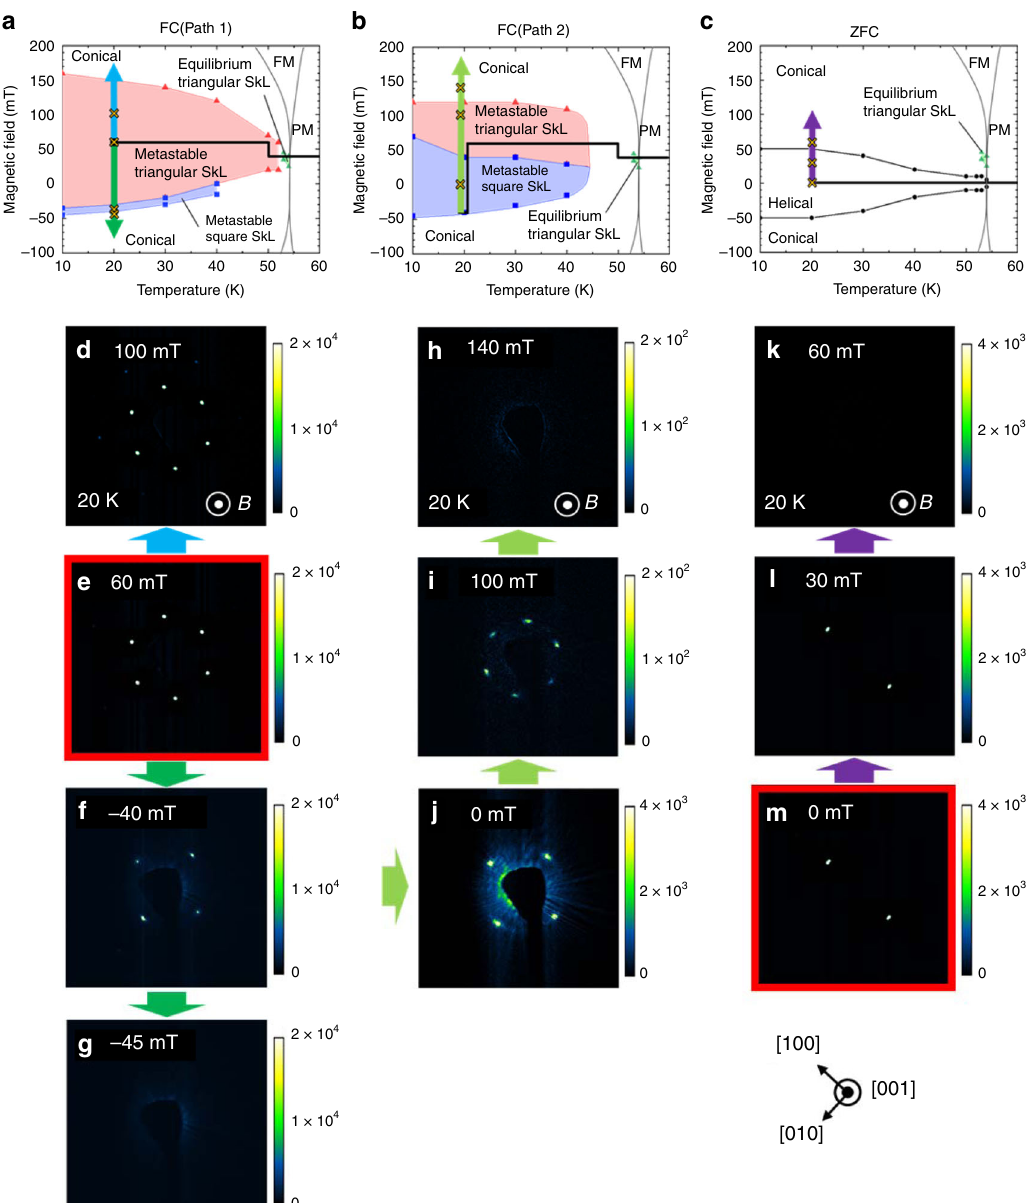
Fig. 2 RSXS diffraction patterns obtained for various fi eld-sweeping paths in Cu 2 OSeO 3 . a – c Magnetic fi eld ( B ) – temperature ( T ) phase diagrams for B || [001], determined from the fi eld-sweeping runs after the different paths of fi eld cooling ( a , b ) and zero- fi eld cooling ( c ) shown by the arrows in each fi gure. FM and PM represent the ferromagnetic and paramagnetic states, respectively. d – m RSXS diffraction patterns taken at 20 K with various amplitudes of magnetic fi eld along the out-of-plane [001] direction in the fi eld-sweeping process of Path 1 ( d – g ) and Path 2 ( h – j ) after FC and after ZFC ( k – m ). The color indicates the scattering intensity. Arrows between these fi gures represent the direction of fi eld sweep, which correspond to the arrows in a – c Cu 2 OSeO 3 hosts helical magnetic order (Fig. 1e) at B = 0, where the neighboring spins rotate within a plane normal to the mag- netic modulation vector Q || < 100 > . The application of a mag- netic fi eld along the out-of-plane [001] direction induces the transition into the conical magnetic phase (Fig. 1d), in which the Q - vector is aligned parallel to the magnetic fi eld (i.e., Q || B ). The equilibrium triangular SkL phase (Fig. 1b) appears in the narrow B – T region just below the magnetic ordering temperature T c , where the spin texture can be approximately described as (cid:6) m ð r Þ ¼ 0 ; 0 ; m z 0